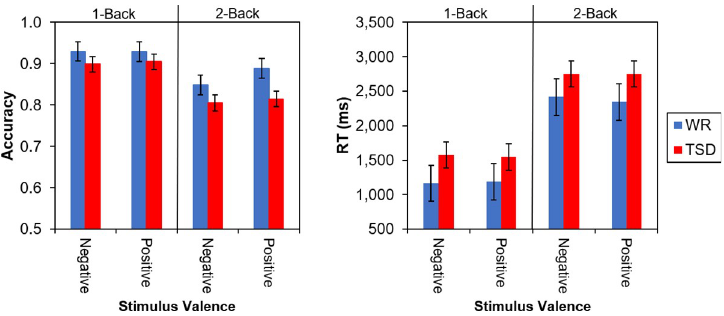
Fig 4. Accuracy (mean ± SE) on the 1- and 2-back blocks of the N-back task, for both positive and negative stimuli, in the TSD (red) and WR (blue) conditions (left). Response time for accurate trials (mean ± SE) on the 1- and 2-back blocks of the N-back task, for both positive and negative stimuli, in the TSD and WR conditions (right).